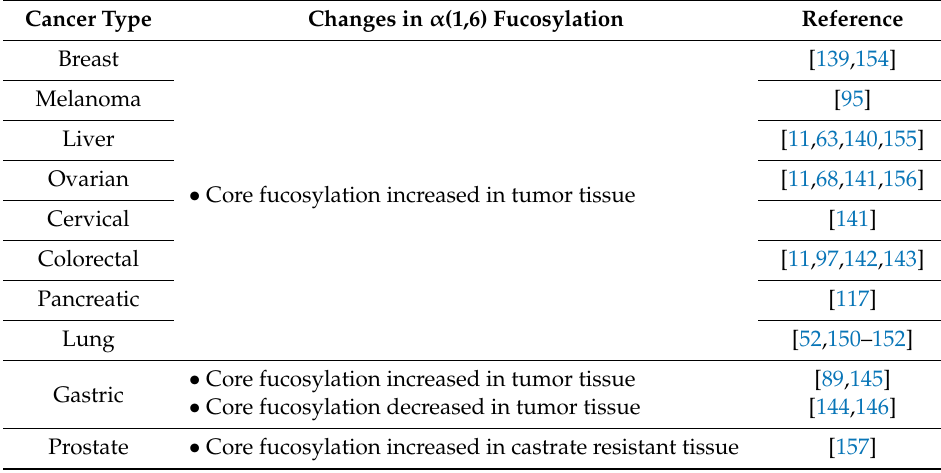
Table 6. Alterations of core fucosylation in tumors.